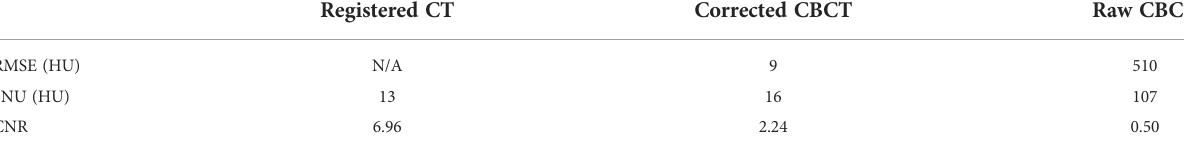
TABLE 2 RMSE, SNU, and CNR in the images of the female phantom.